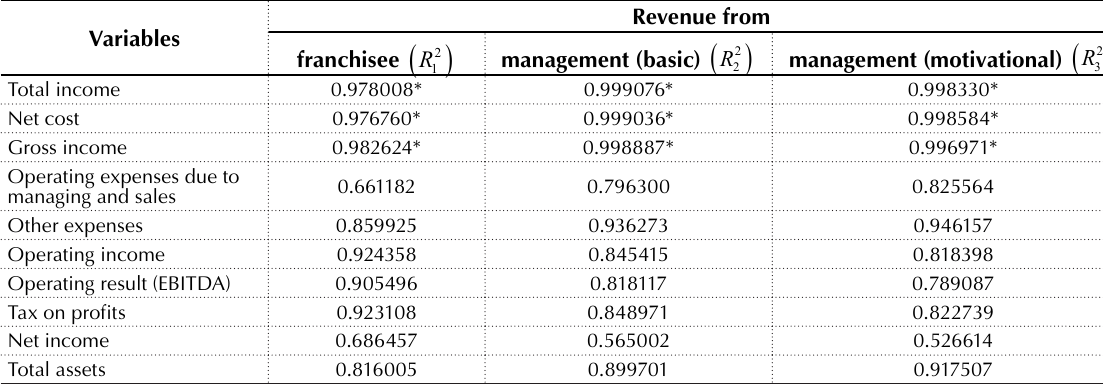
Table 3. The regression analysis results for